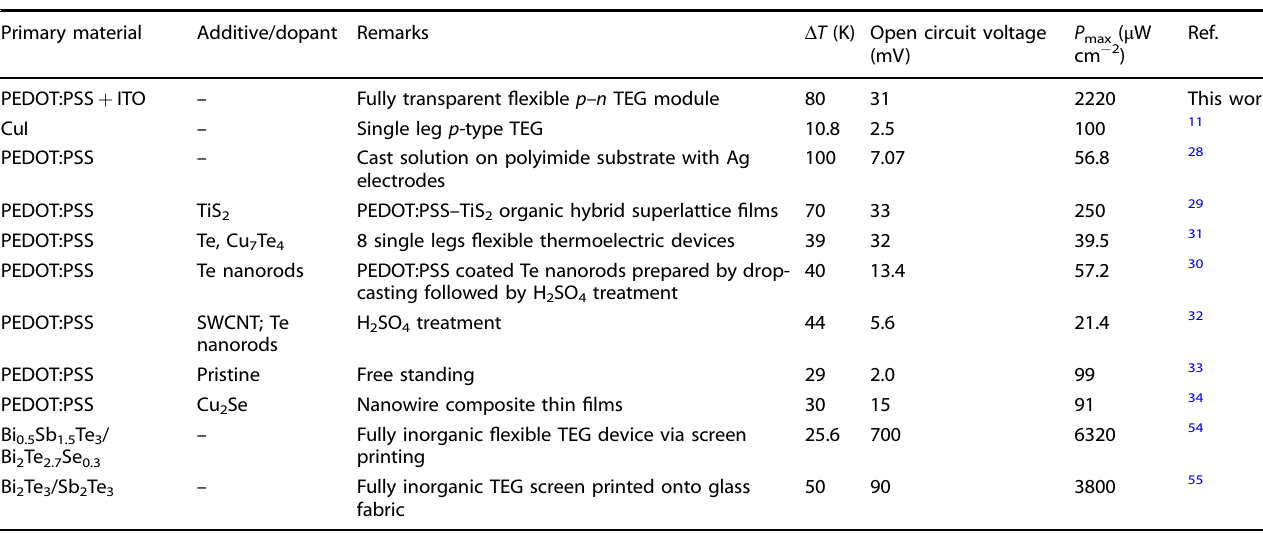
Fig. 6 Device properties of both p- type and n- type thermoelectrics. a Electrical conductivity and Seebeck coef fi cient of p -type PEDOT:PSS thin fi lm, with post-treatment, as a function of temperature. b A diagram of an in-plane transparent thermoelectric generator illustrating the basic con fi guration of p -type and n -type thermoelectric legs deposited onto a substrate without any electrodes. c Transmittance spectra and d photo of the thermoelectric module on polyethylene terephthalate (PET) sheets and glass. e Output current ( I out ) and f output power ( P out ) of the thermoelectric module on glass, as a function of output voltage ( V out ) for different temperature Table 2. Literature comparison of TEG module performances.